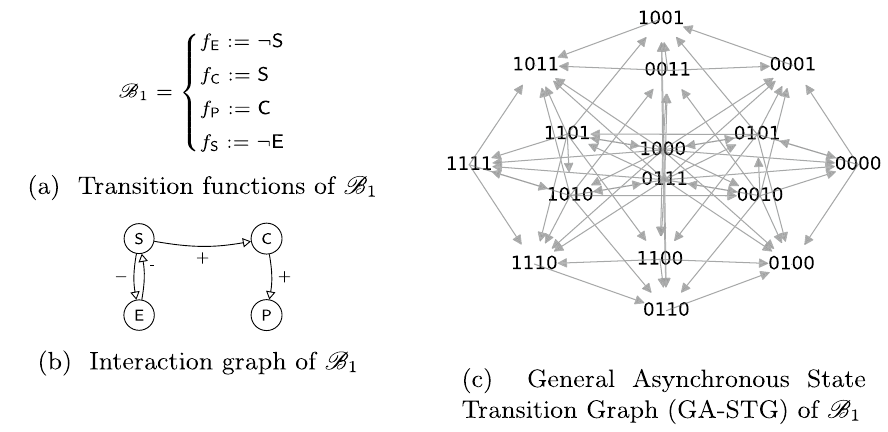
Fig. 1 Example of a Boolean network to model Eq.